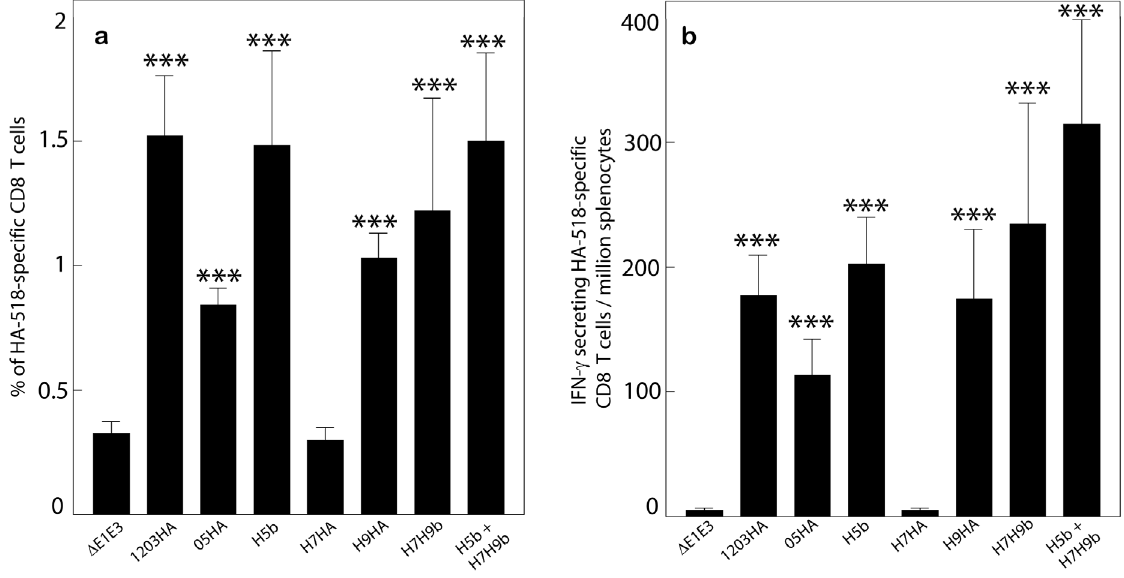
Figure 2. Induction of HA518 epitope pentamer-specific CD8 + T cells and ELISpot measurements of IFN- c expression in spleen cells of vaccinated mice. Mice (7 animals/group) were immunized with 1203HA, 05HA, H5b, H7HA, H9HA, H7H9b, H5b + H7H9b or D E1E3 twice at four- week intervals. At four weeks after booster inoculation, the animals were euthanized, and the spleens were collected for the evaluation of HA-specific CMI responses using HA518 epitope-specific pentamer staining (a) and IFN- c -ELISpot assay (b) as described under Materials and Methods. The data represent mean 6 standard deviation (SD) from 7 animals/group. ***; P # 0.005. 1203HA, HAd-1203HA; 05HA, HAd-05HA; H5b, HAd-1203HA-05HA; H7HA, HAd-H7HA; H9HA, HAd-H9HA; H7H9b, HAd-H7HA-H9HA; H5b + H7H9b; HAd-1203HA-05HA + HAd-H7HA-H9HA; D E1E3, HAd- D E1E3.